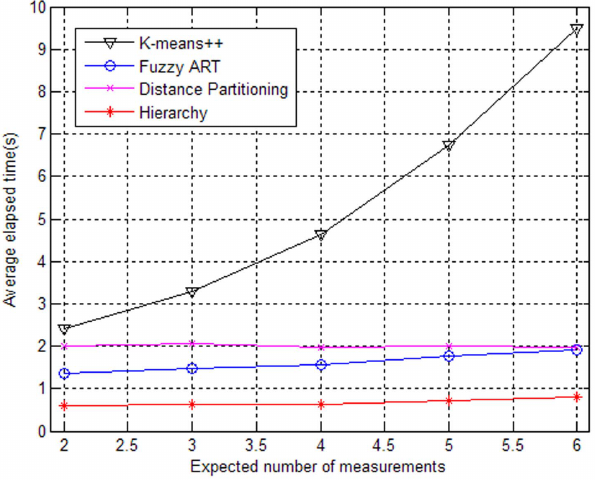
Figure 3. Elapsed times of partitioning algorithms versus expected number of